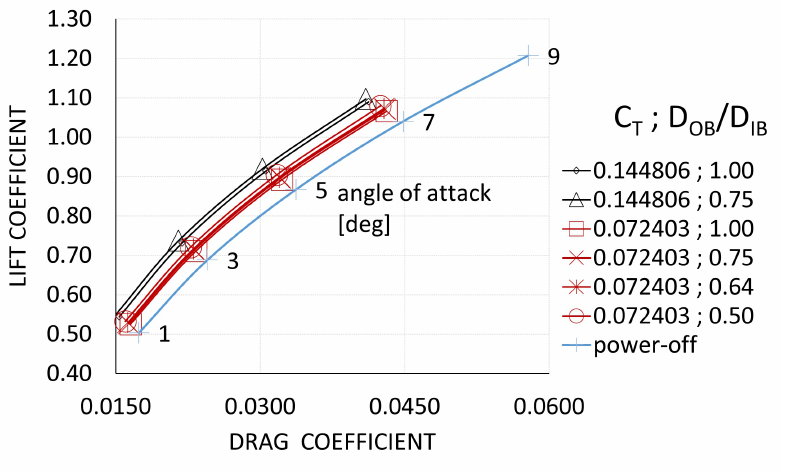
Figure 7. Drag polar curves: effect of OB propeller only, climb conditions ( M = 0.251; Re = 12.8 × 10 6 ).